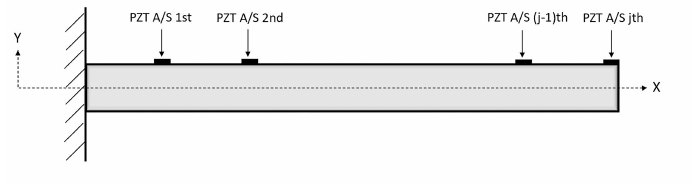
Figure 1. Representative shape of the beam including piezoelectric